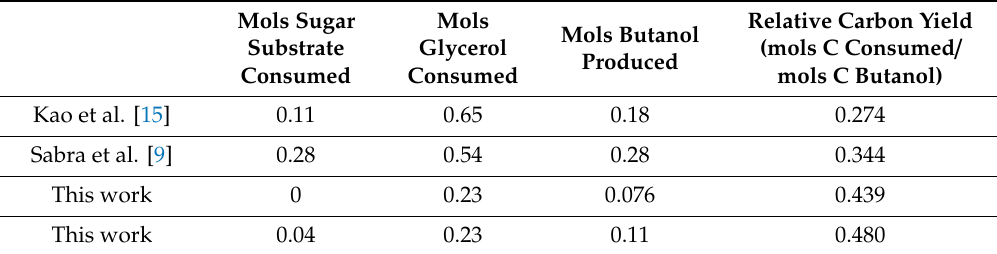
Figure 6. Top: Off gas (CO 2 and H 2 ) of the molasses/glycerol fermentation with C. pasteurianum . First drop in gas production corresponds to depletion of fructose, second drop corresponds to depletion of dextrose. Bottom: Substrates and products of fermentation over time. Conditions were tested in duplicate, with the mean of the results presented. Deviation from the mean was less than 5% for all samples. Table 5. Comparison of the relative carbon yield for dual-substrate fermentations (ratio of carbon in the available substrates over the carbon in the main product,